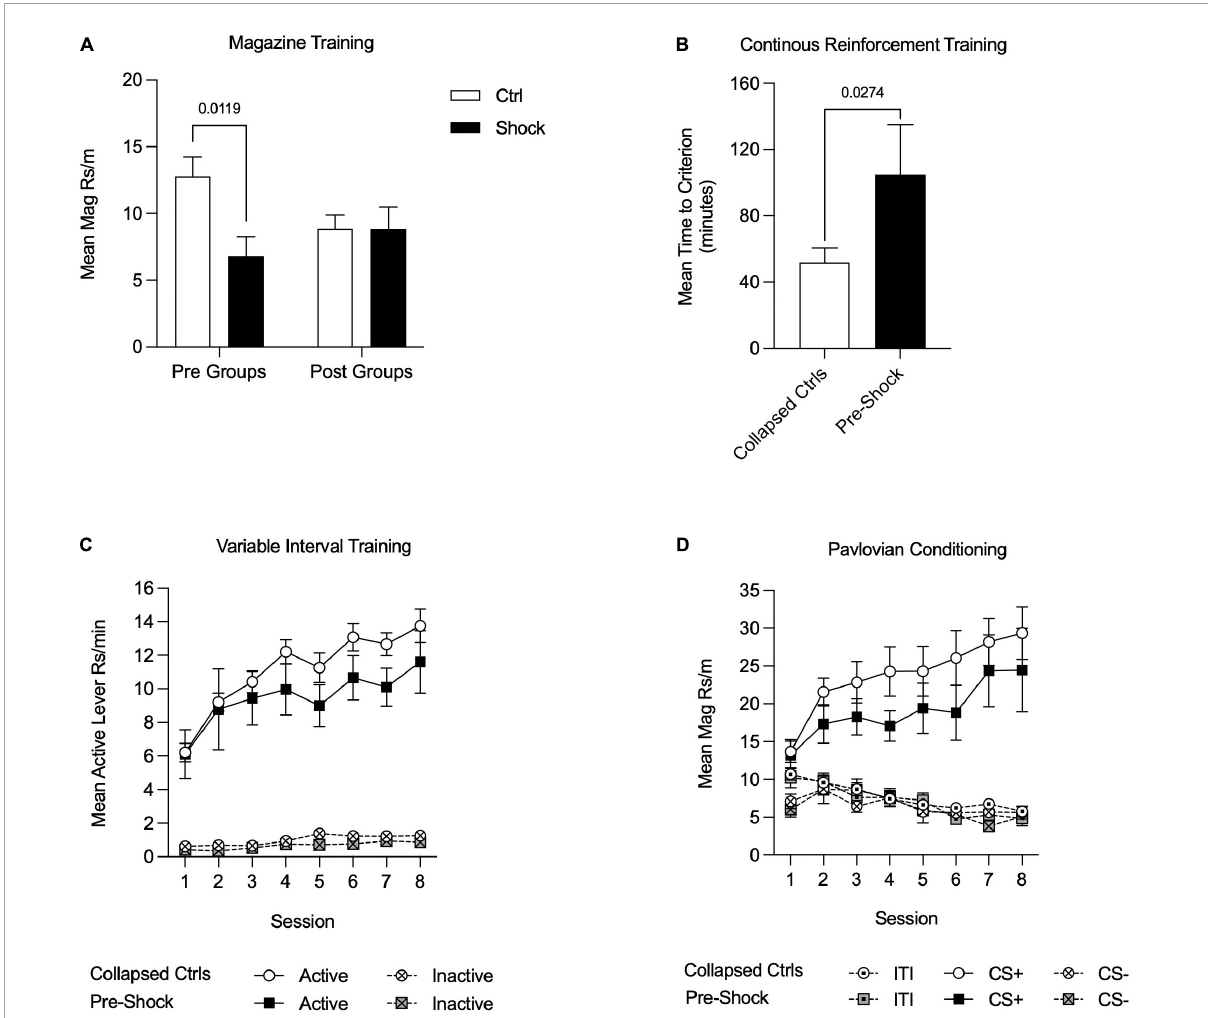
FIGURE3 Appetitive training in Context B in Experiment 1. Data are collapsed between Pre-Ctrl, Post-Ctrl, and Post-Shock groups when measures did not differ between these groups. (A) Magazine training was suppressed in the Pre-Shock group relative to the pre-control group and there were no differences between the post groups. (B) Acquisition on a continuous reinforcement schedule was slower in the Pre-Shock group compared to the other groups. (C) During variable interval training, response rates increased across sessions and did not differ between Pre-Shock rats and the Collapsed Ctrl. Inactive lever responding was significantly lower than Active lever responding across sessions. (D) During Pavlovian conditioning, the mean rate of magazine responding during CS+ presentations increased across sessions and there were no group differences between Pre-Shock and Collapsed Ctrl Groups in